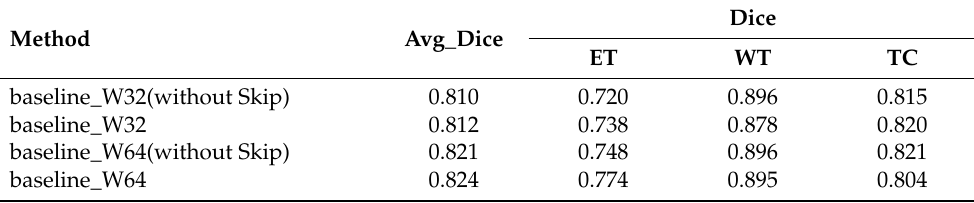
Table 7. The evaluation metrics of baseline using different methods. Here, baseline_W32 and and without Skip represents the removal of the Skip operation. Avg_Dice refers to the average Dice of the three tumor